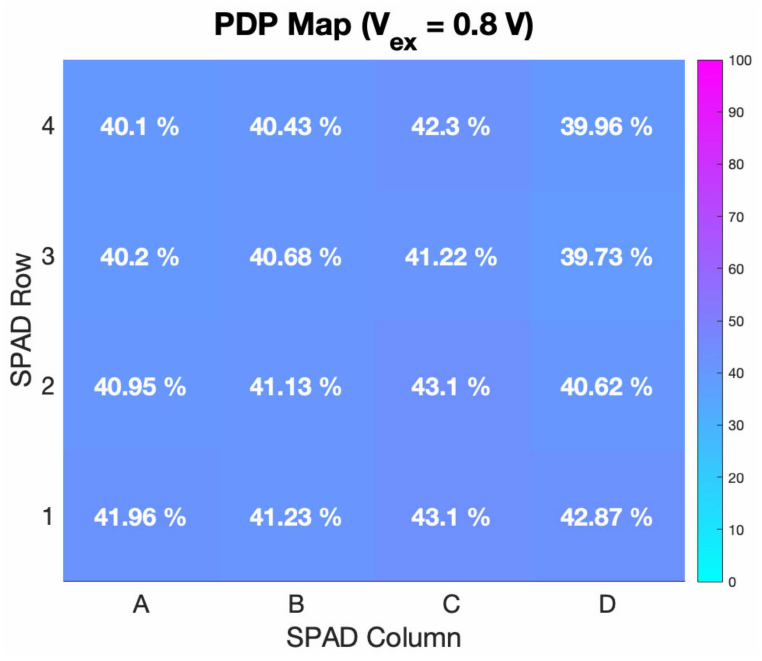
Figure 13. Peak PDP map (i.e., 420 nm) for the array with a 0.8 V excess